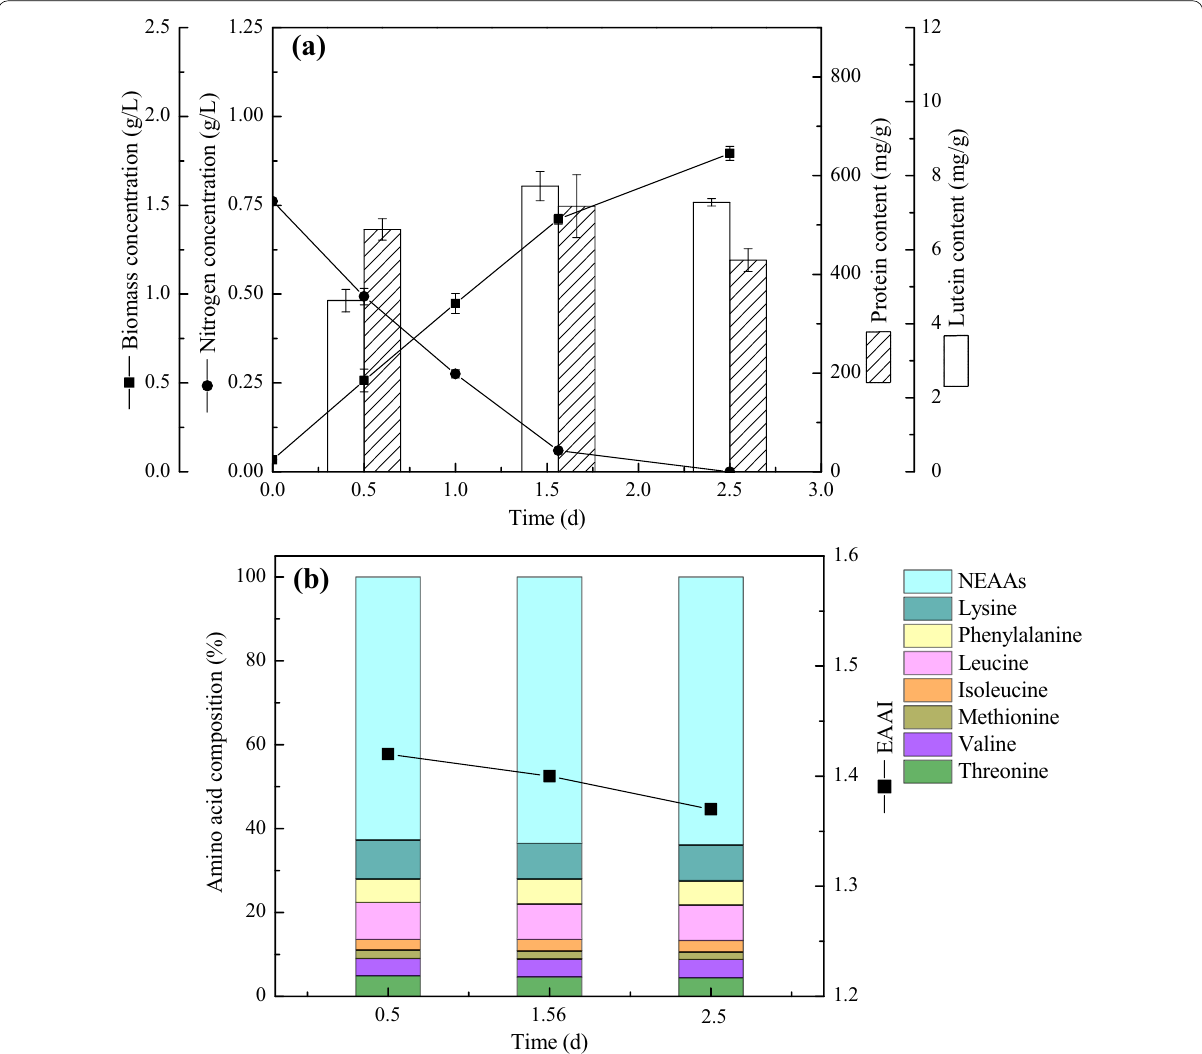
Fig. 1 Cell growth and lutein and protein accumulation of C. sorokiniana FZU60 under batch cultivation. a Biomass concentration, nitrogen concentration, lutein content, and protein content; b amino acid